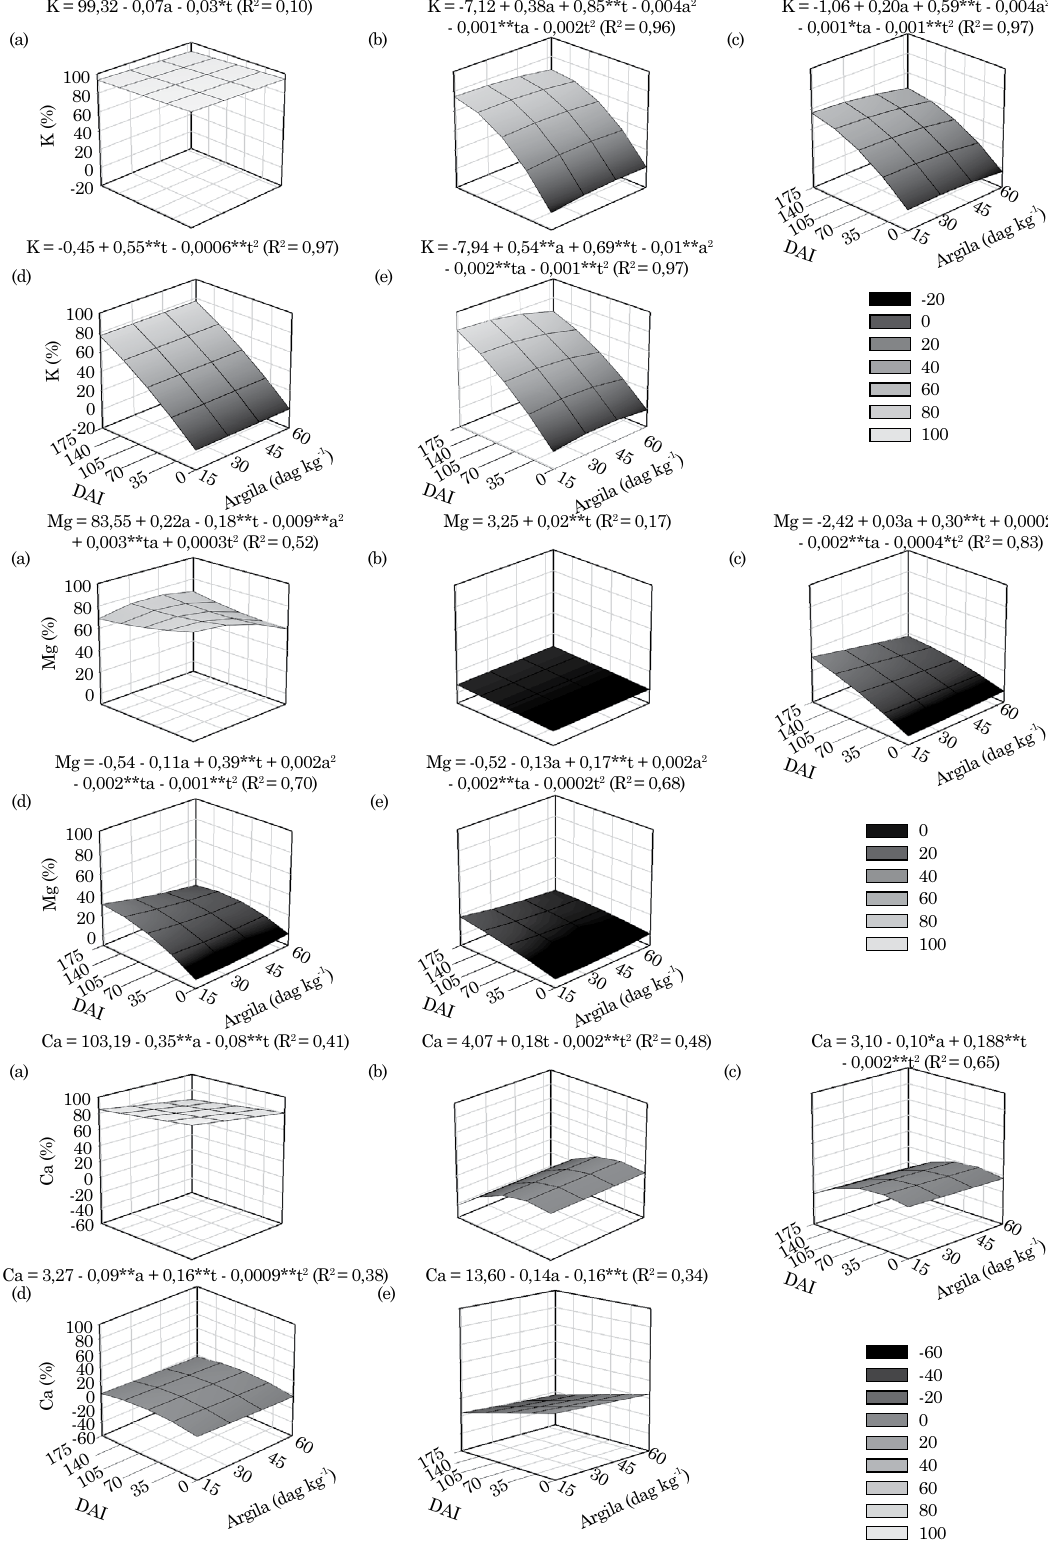
figura 5. taxas de recuperação do K, ca e mg, pelos extratores, nos solos com fontes inorgânicas dos nutrientes (a); e com resíduo de: milho (b), braquiária (c), feijão (d) e estilosantes (e). * e **: significativos a 5 e 1 %, respectivamente, referentes a: a – teor de argila, t – tempo e ta – interação entre esses. Dai: dias após o início da